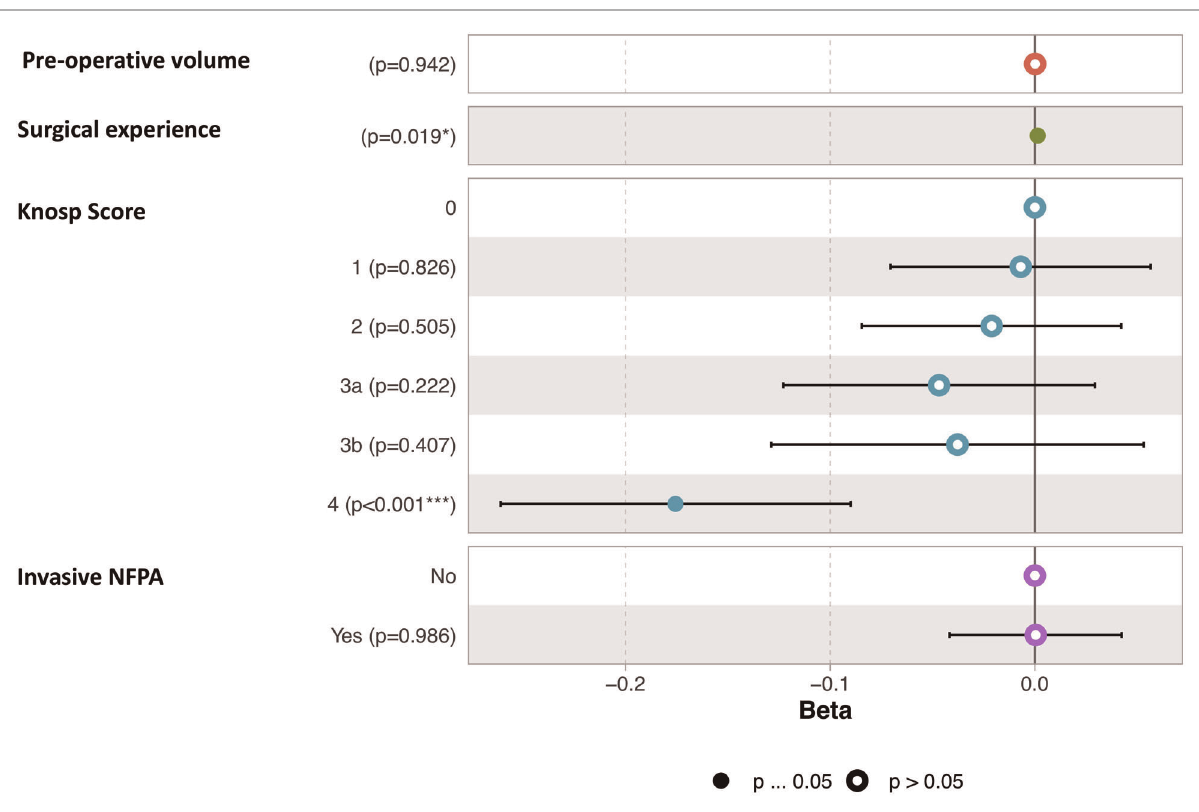
FIGURE 2 Graphic representation of the multiple linear regression model of factors correlated to EOR. The term “ invasive ” refers to the Hypopronos classi fi